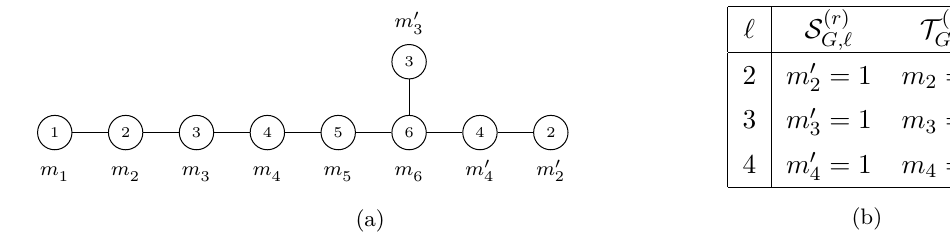
(a) The Kac labels { m P 6 = ‘ to define an embedding Z a i m i + P 4 a 0 m 0 j j i =1 j =2